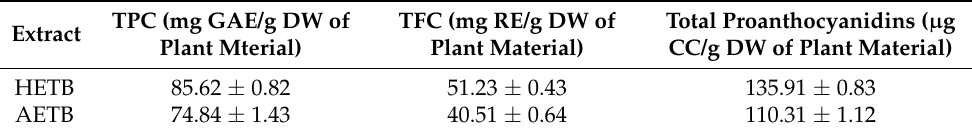
Table 2. Chemical characterization of TPC and TFC and total proanthocyanidins in HETB and AETB. TPC (mg GAE/g DW of TFC (mg RE/g DW of Extract Plant Mterial) Plant